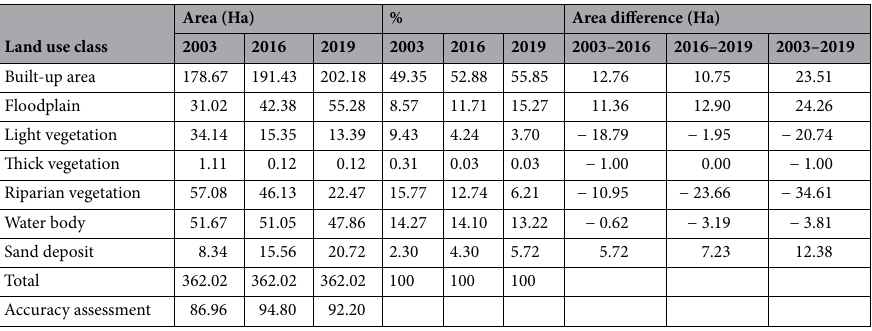
pin data from Reach 3 (Fig. 5a). Bank retreat generally occurred during the rainy season with the highest ero- sion rate of ~ 2.3 cm in October, while negligible retreat or small deposition of talus material at the bank toe